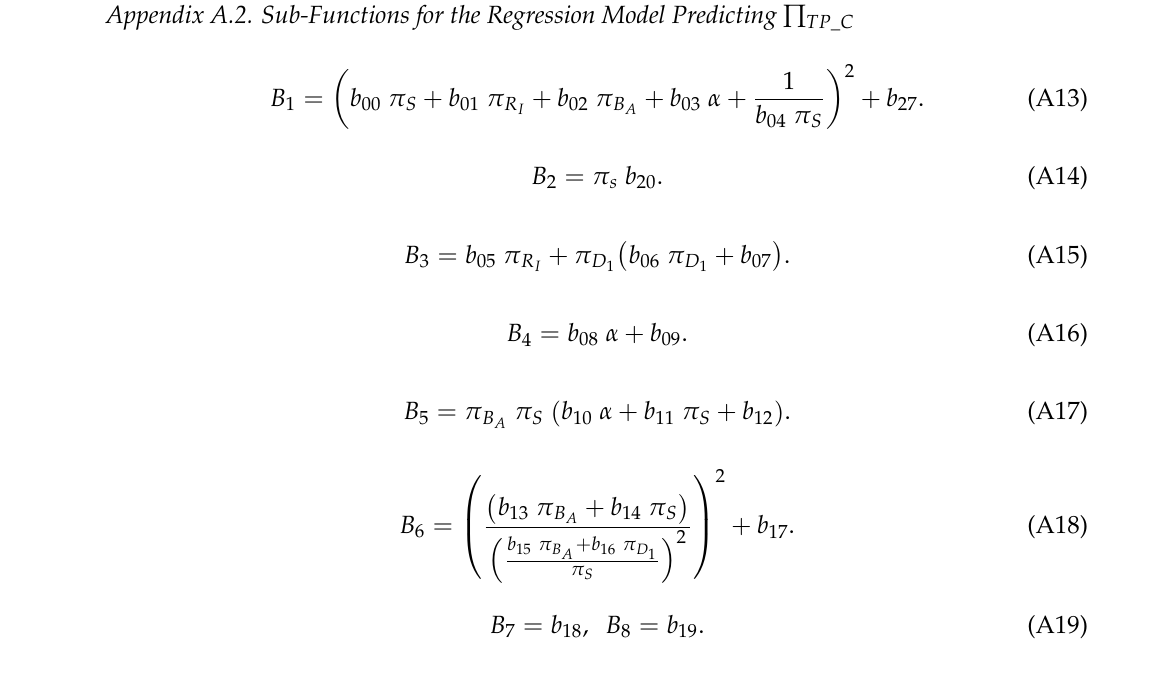
Table A2. Rounded values of the constant for Equation